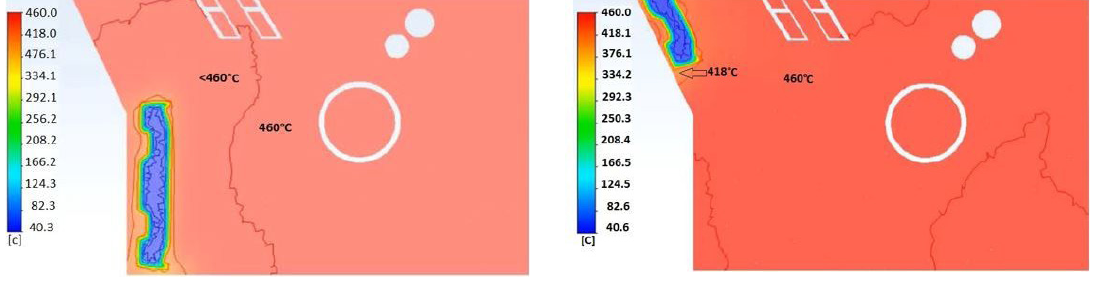
Figure 7. Temperature distribution with the solid ingot at 40° C fully inserted into the zinc bath.